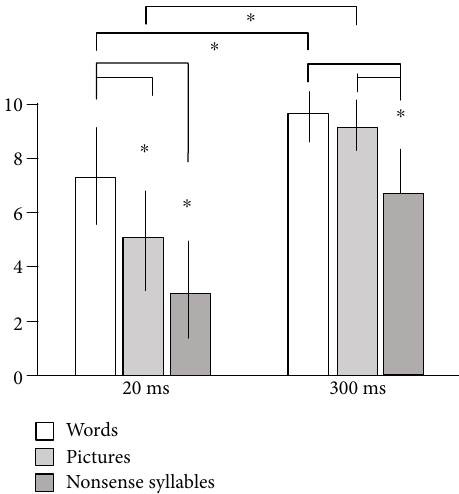
Figure 3: E ff ect of the types of stimuli in the AD group. AD = Alzheimer ’ s disease. ∗ p < 0 : 001 , post hoc. The y -axis represents the average number of correct responses with SD. There was a signi fi cant e ff ect of the type of stimuli ( F = 89 : 2 , p < 0 : 001 ) and the presentation time e ff ect ( F = 192 : 1 , p < 0 : 001 ) with a signi fi cant interaction ( F = 9 : 1 , p < 0 : 001 ) using the two-way ANOVA with repeated measures. From the paired t -test as a post hoc test in 20 ms, the picture ’ s scores were signi fi cantly lower than word ’ s scores ( t = − 6 : 89 , p < 0 : 001 ), and nonsense syllables ’ scores were signi fi cantly lower than word ’ s scores ( t = − 11 : 54 , p < 0 : 001 ). Nonsense syllables ’ scores were signi fi cantly lower than picture ’ s scores ( t = − 4 : 68 , p < 0 : 001 ), with a correct response. From the paired t -test as a post hoc test in 300ms, nonsense syllables ’ scores were signi fi cantly less than word ’ s scores ( t = − 8 : 93 , p < 0 : 001 ), and nonsense syllables ’ scores were signi fi cantly less than picture ’ s scores ( t = − 7 : 88 , p < 0 : 001